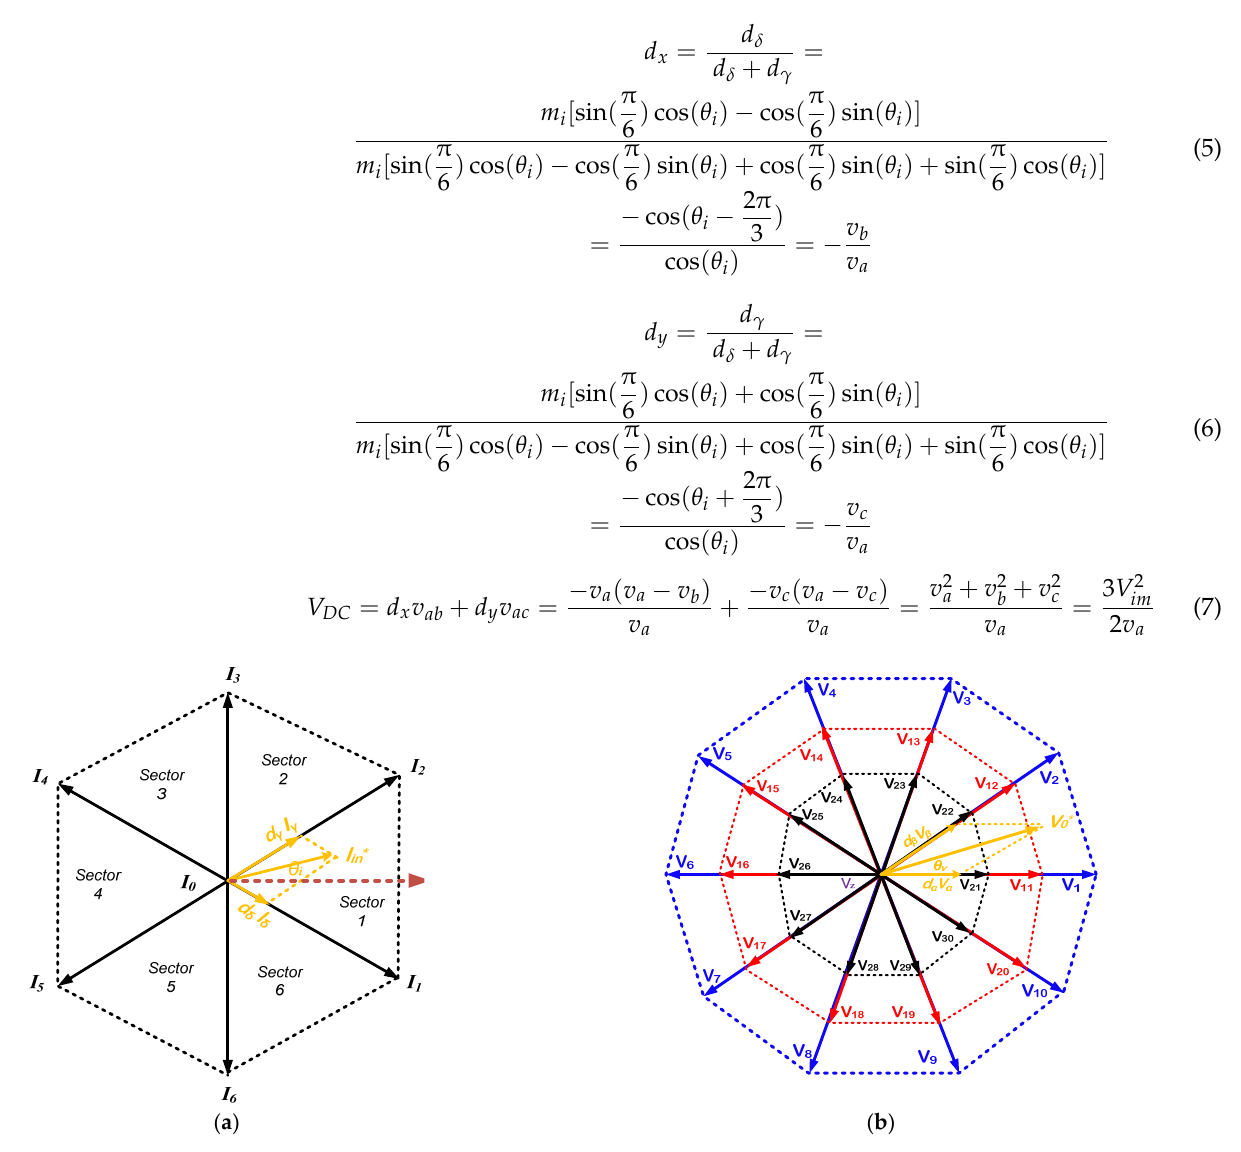
Figure 2. ( a ) The rectifier’s hexagon and ( b ) the inverter’s decagon. Table 1. The switching states, the duty cycles, and the DC-link voltage for the rectifier in all sectors.